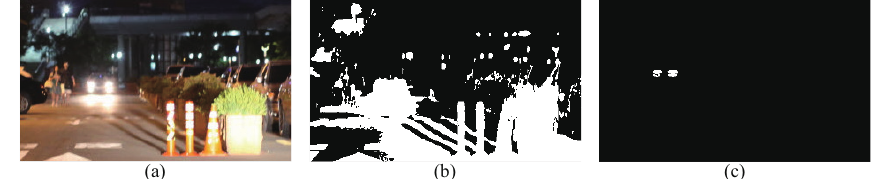
Figure 15. Results of headlight detection ( a ) test scene (RGB picture), ( b ) using the RGB image ( c ) using hyperspectral image.